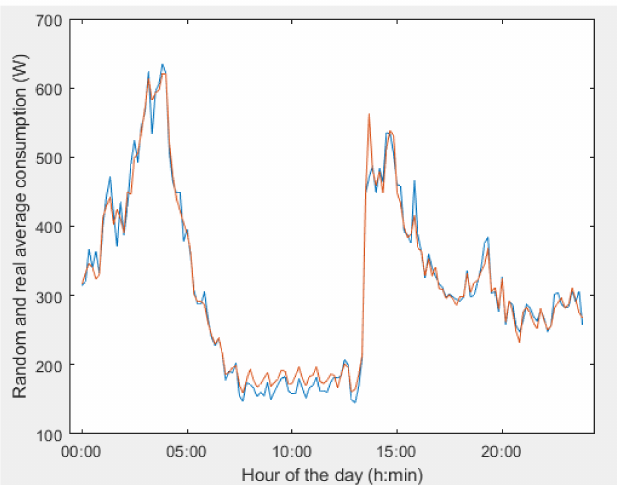
Figure 4. Random (blue) and real (orange) average consumption of the lighting during working days.